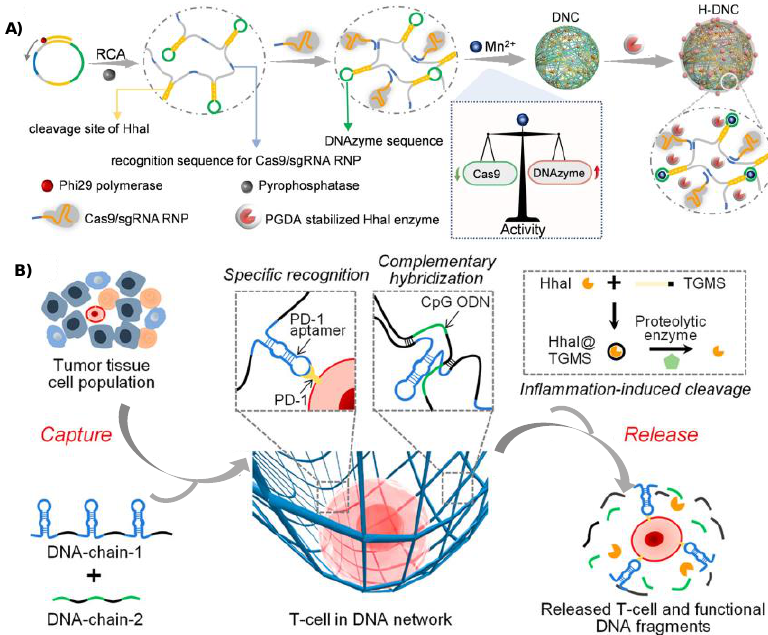
Figure 7. RCA technology-based DNA hydrogel for cancer therapy. ( A ) The principle of RCA strategy-based DNA nanogel for the co-delivery of DNAzyme and CRISPR/Cas 9 for gene therapy. Reproduced with permission. Copyright 2022 [55], Wiley-VCH Verlag GmbH. ( B ) Double RCA assembly strategy formed DNA hydrogel for the isolation and release of T cells for cancer immunotherapy. Copyright 2021 [56], the American Chemical Society.